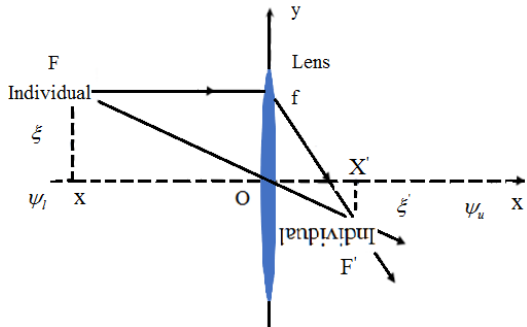
Figure 2. Strategy of dynamic lens-imaging learning.